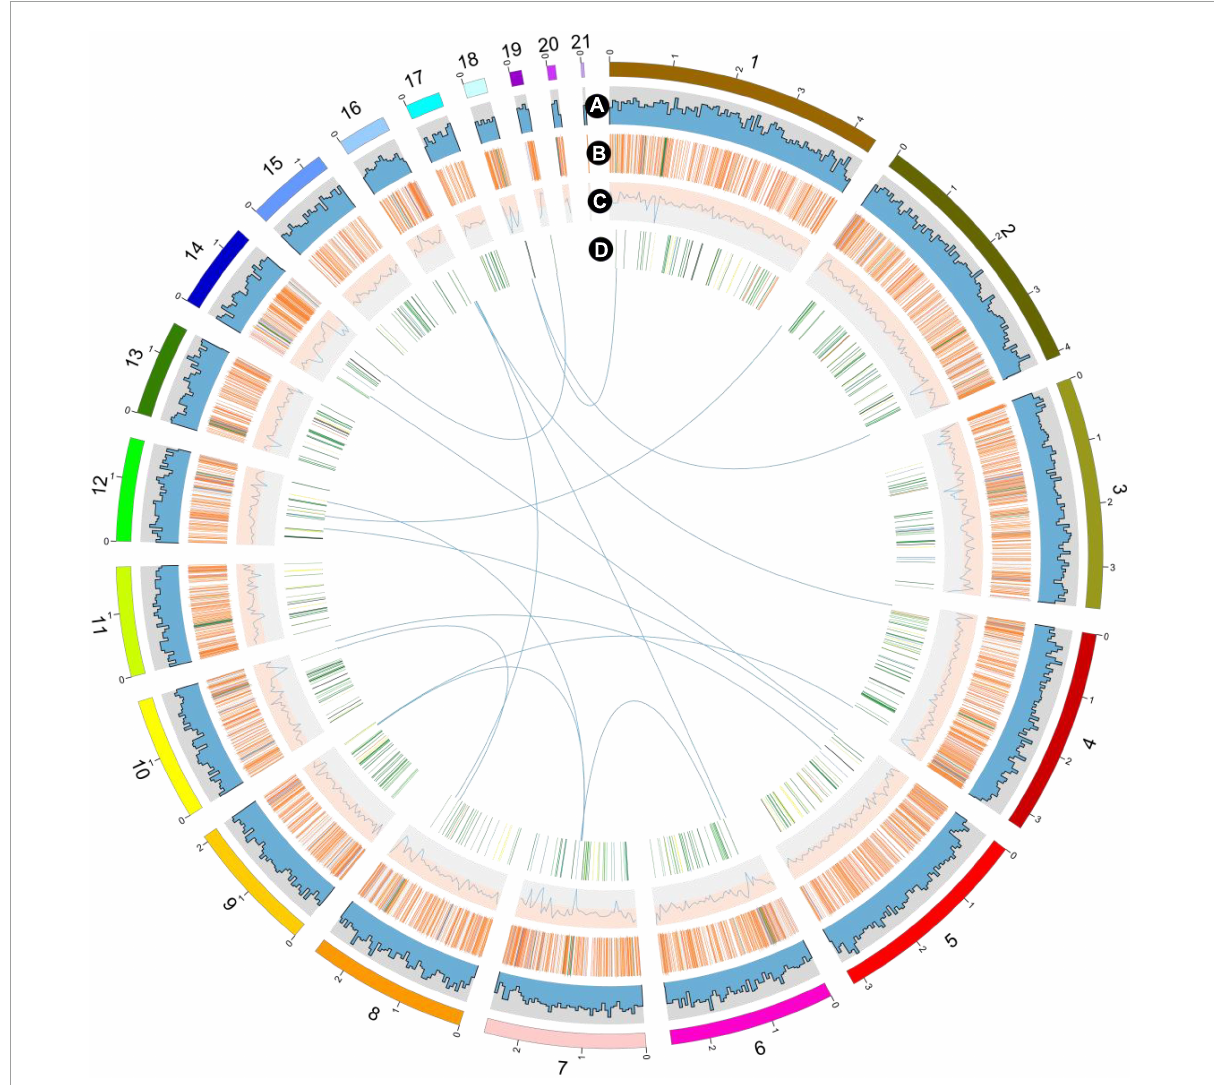
FIGURE2 Overview of the P. giganteus genome assembly. The outermost layer of colored blocks is a circular representation of the 21 contigs with coding sequences, with a scale mark labeling each 1 Mb. (A) Gene density per window. (B) Repeat sequence density per window. (C) GC content per window. (D) carbohydrate-active enzymes (CAZymes). Links within and between chromosomes represent collinear blocks generated from MCScanX and JCVI software. For tracks (A–C) , the window size is 50 kb. The plot was visualized using Circos